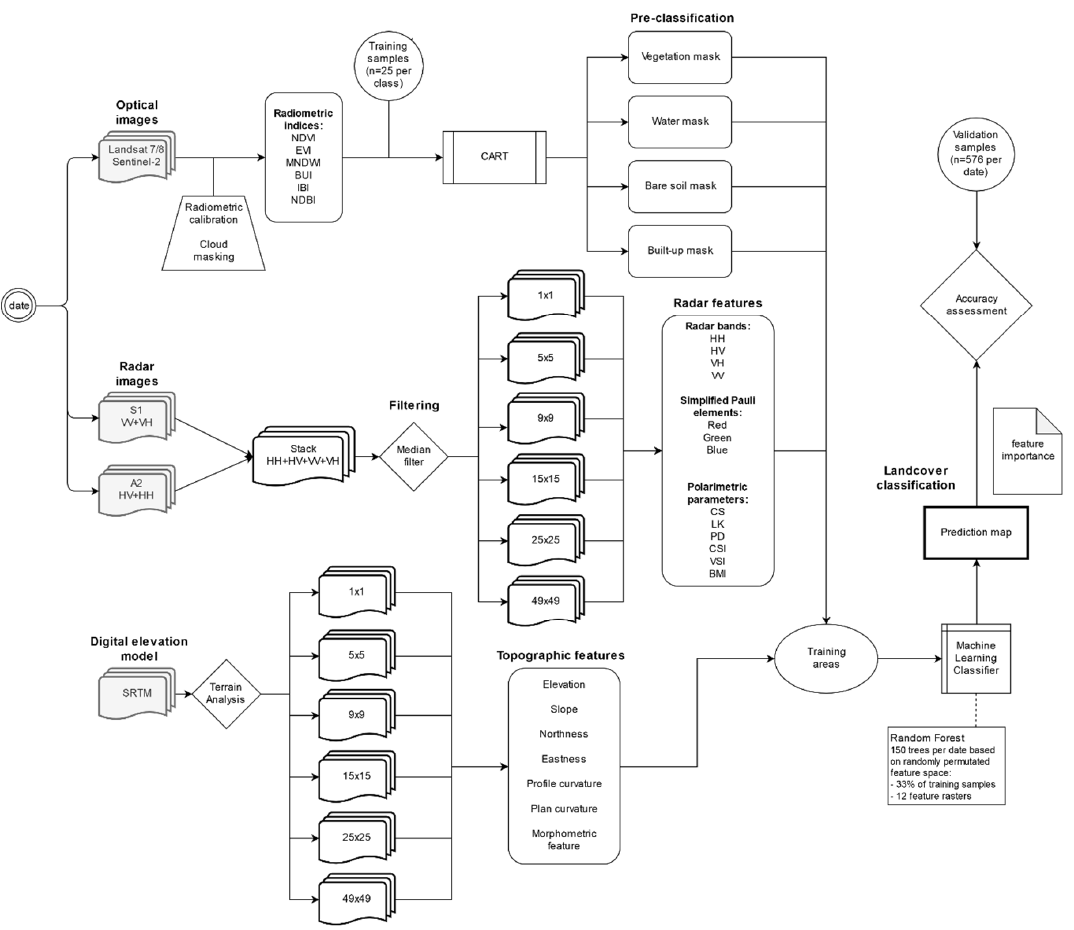
Figure 2. Workflow of the landcover classification for the area around Kutupalong. NDVI = Normalized Difference Vegetation Index, EVI = Enhanced Vegetation Index, MNDWI = Modified Normalized Difference Water Index, BUI = Built-up Index, IBI = Index-based Built-up Index, NDBI = Normalized Difference Build-up Index, HH = horizontal–horizontal, HV = horizontal–vertical, VH = vertical–horizontal, VV = vertical–vertical, S1 = Sentinel-1, A2 = ALOS-2, SRTM = Shuttle Radar Topography Mission, CART = Classification and Regression Tree, LK = average like-polarized magnitude, CS = average cross-polarized magnitude, CSI = Canopy Structure Index, VSI = Volume Scattering Index.